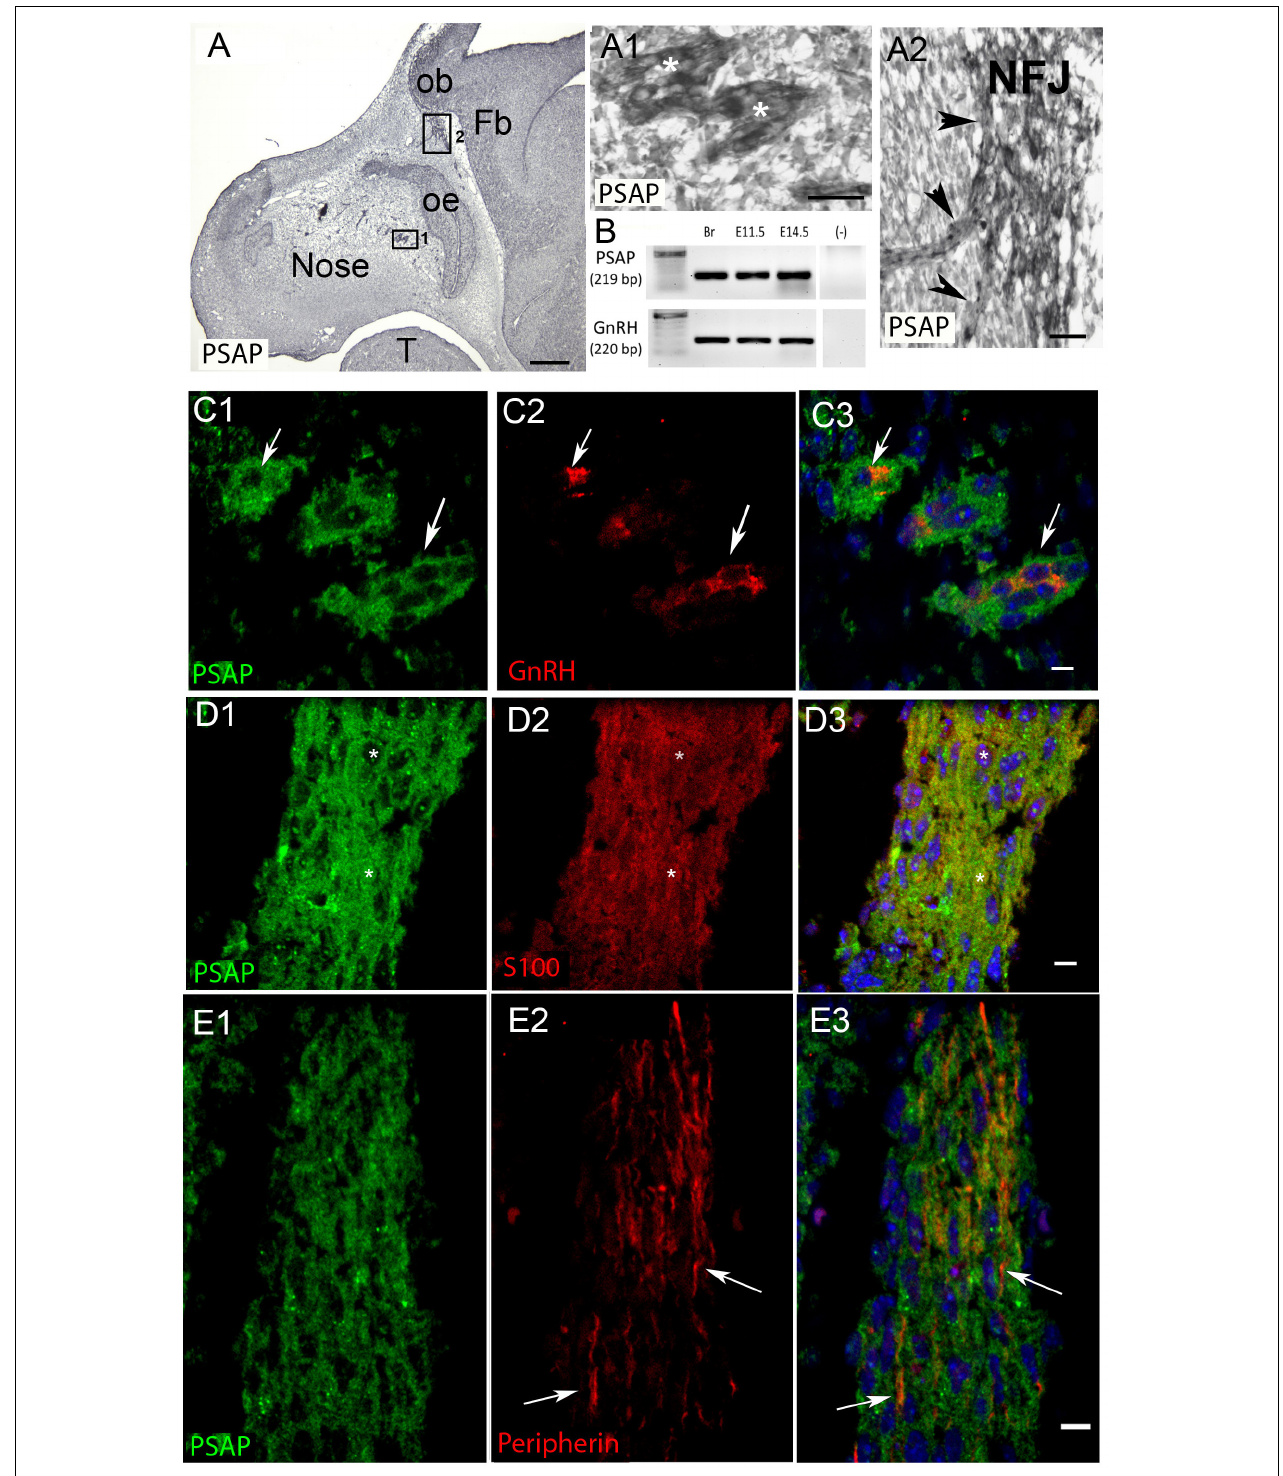
FIGURE 4 | PSAP is expressed in GnRH neurons and OECs in the developing nasal region. (A) Immunocytochemistry for PSAP in a E12.5 embryo shows positive signal in tracts ( A1 , high magnification of boxed area 1 in A , asterisks) that converge at the nasal forebrain junction ( A2 , high magnification of boxed area 2 in A , NFJ). (B) PCR confirmed PSAP transcripts in nose region from E11.5 and E14.5 embryos [positive control brain (Br), negative control water ( − ), tissue control PCR for GnRH transcripts]. (C–E) . PSAP (green) colocalized with GnRH neurons (red, arrows C ) and OECS (red, D ), but was not present on OSAs (red, arrows E ). All sections are from a E12.5 embryo. Panel 3 is merged image of corresponding row. Scale bar: (A) = 250 µ m, (A1,A2) = 25 µ m (C–E) = 10 µ m.